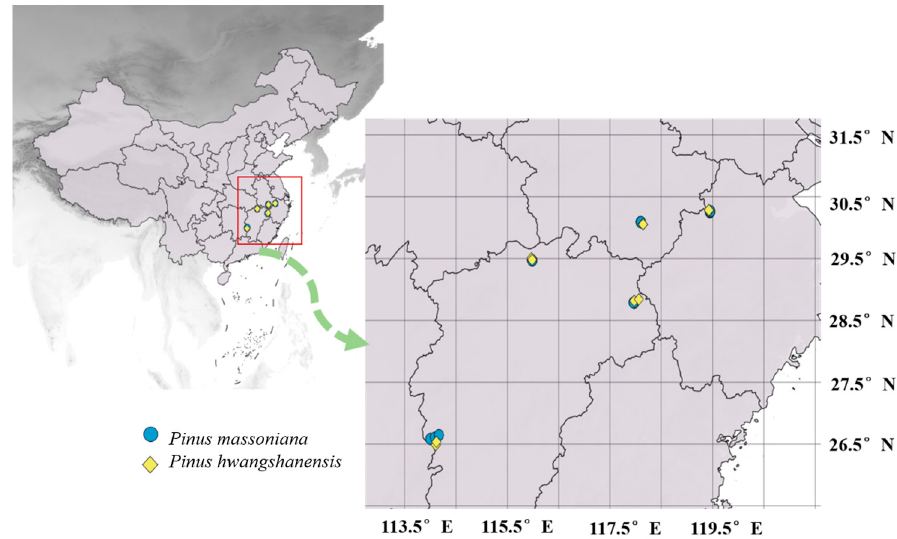
Figure 3. Distribution of the sampling points. Blue icons stand for P. massoniana , yellow icons stand for P. hwangshanensis.